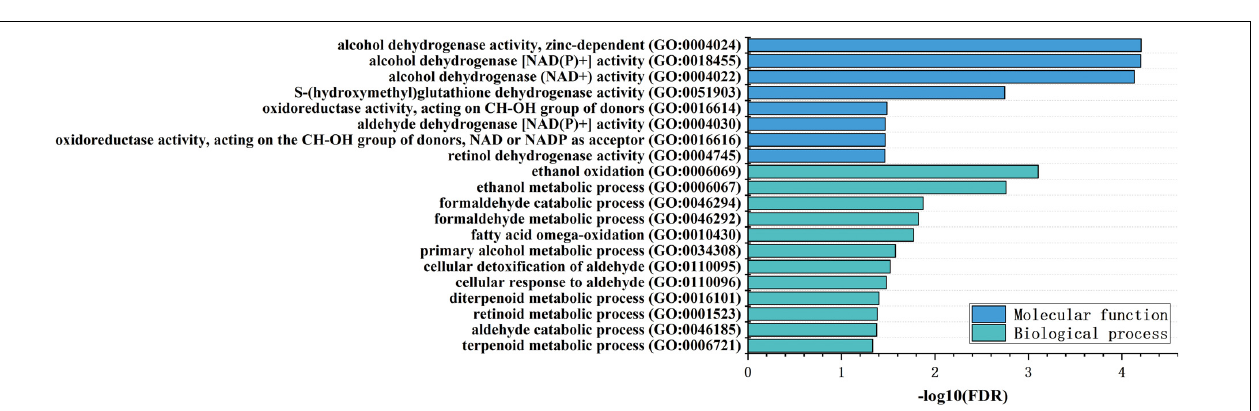
FIGURE 3 | A bar graph of GO function enrichment for gingivitis-related